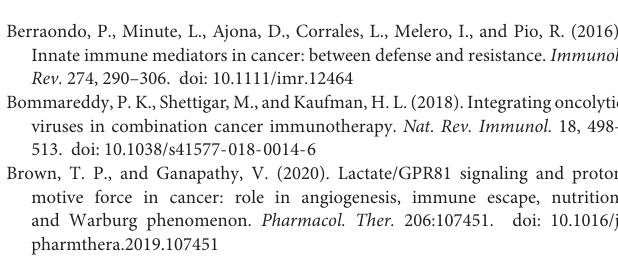
Supplementary Figure 1 | No correlation between the ESTIMATE scores with the DFS and OS for 65 patients. Supplementary Figure 2 | (A) Top 5 genes in purple module were upregulated in pancreatic cancer. (B,C) Top 5 genes in purple module were correlated with DFS and OS of patients with pancreatic